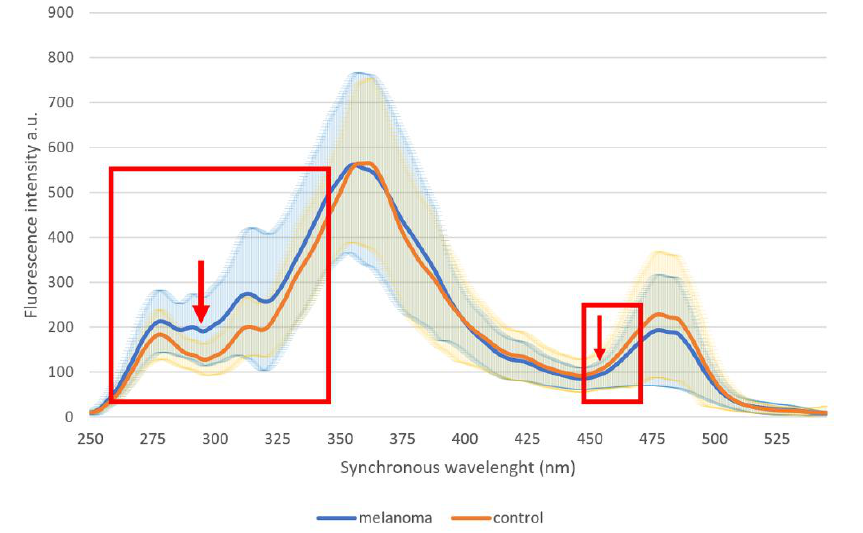
Figure 1. Average fluorescence profiles of urine in the control group and whole malignant melanoma group. Rectangles indicate wavelength areas with significant differences; arrows indicate wavelengths with the largest statistical difference. Table 1. Comparison of fluorescence intensity at various wavelengths through whole measured spectrum (in 25 nm steps) in healthy and control group. For evaluation of differences, Student’s t -test was used. Values of fluorescence intensity are expressed as mean ±